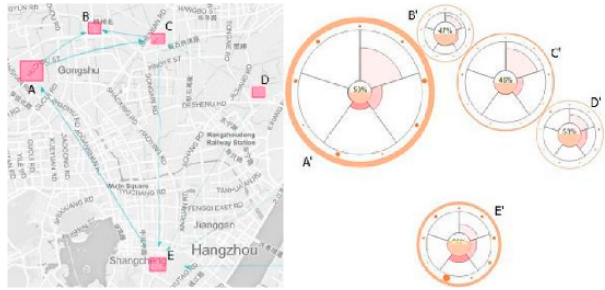
Figure 3. Example of radial icon visualization [5].